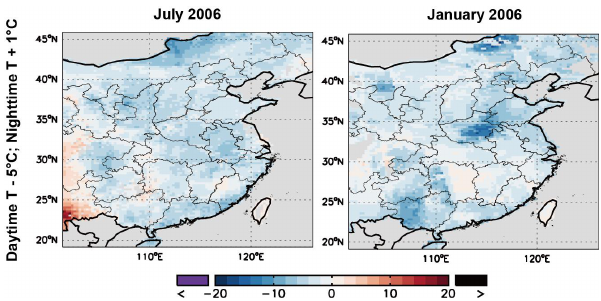
Fig. 3. Spatial distribution of percentage differences between mod- eled NO 2 columns with and without adjustments in air temperature: the daytime temperature is decreased by 5 ◦ C with an increase of 1 ◦ C at night for the lowest 10 model layers. See Fig. S9 for more results of sensitivity tests on